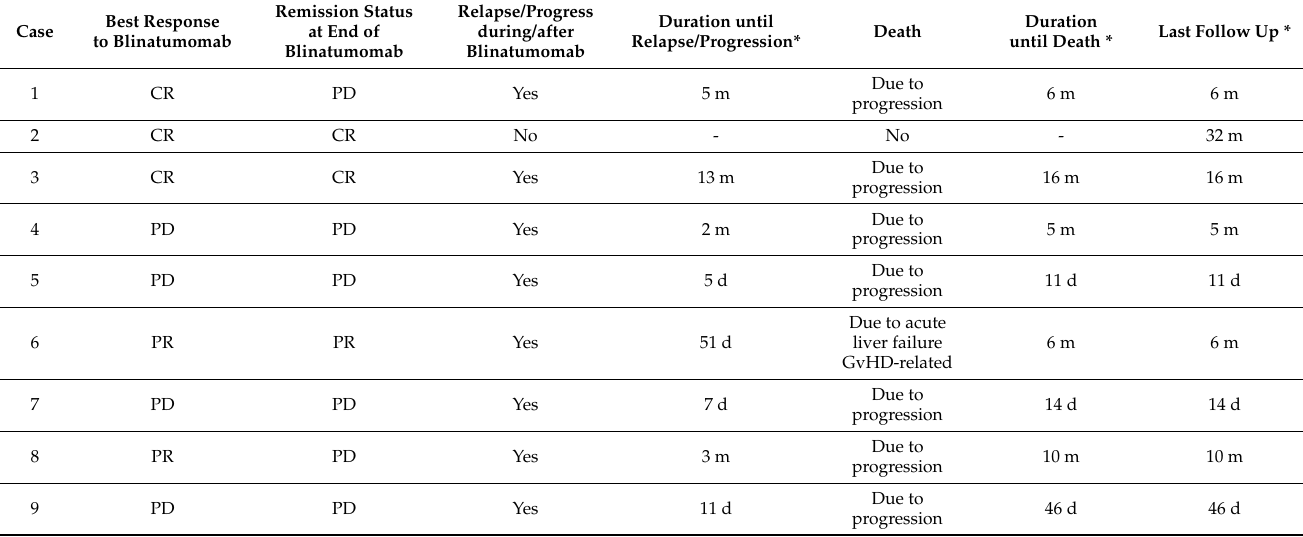
Table 5. Outcome of blinatumomab therapy; presentation of data on each